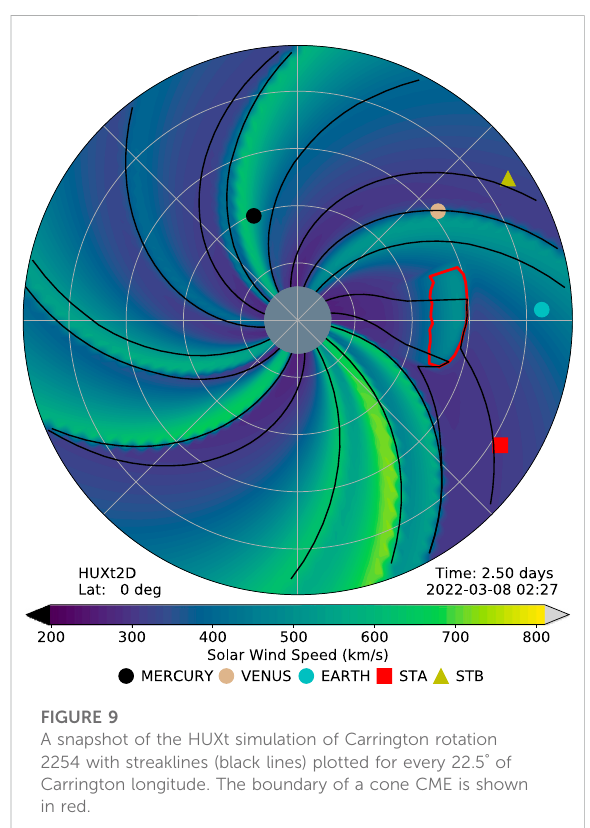
A snapshot of the HUXt simulation of Carrington rotation 2254 with streaklines (black lines) plotted for every 22.5 ° of Carrington longitude. The boundary of a cone CME is shown in